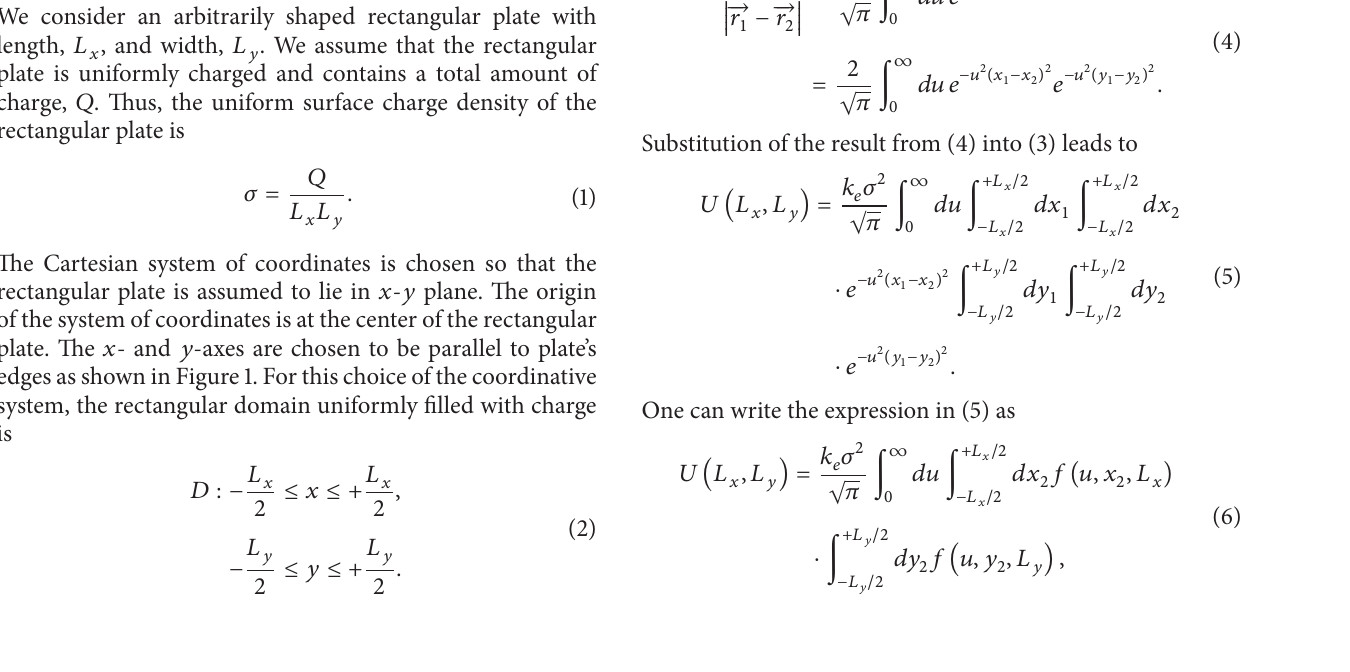
𝑑𝑞 = 𝜎𝑑 2 𝑟 1 and 2